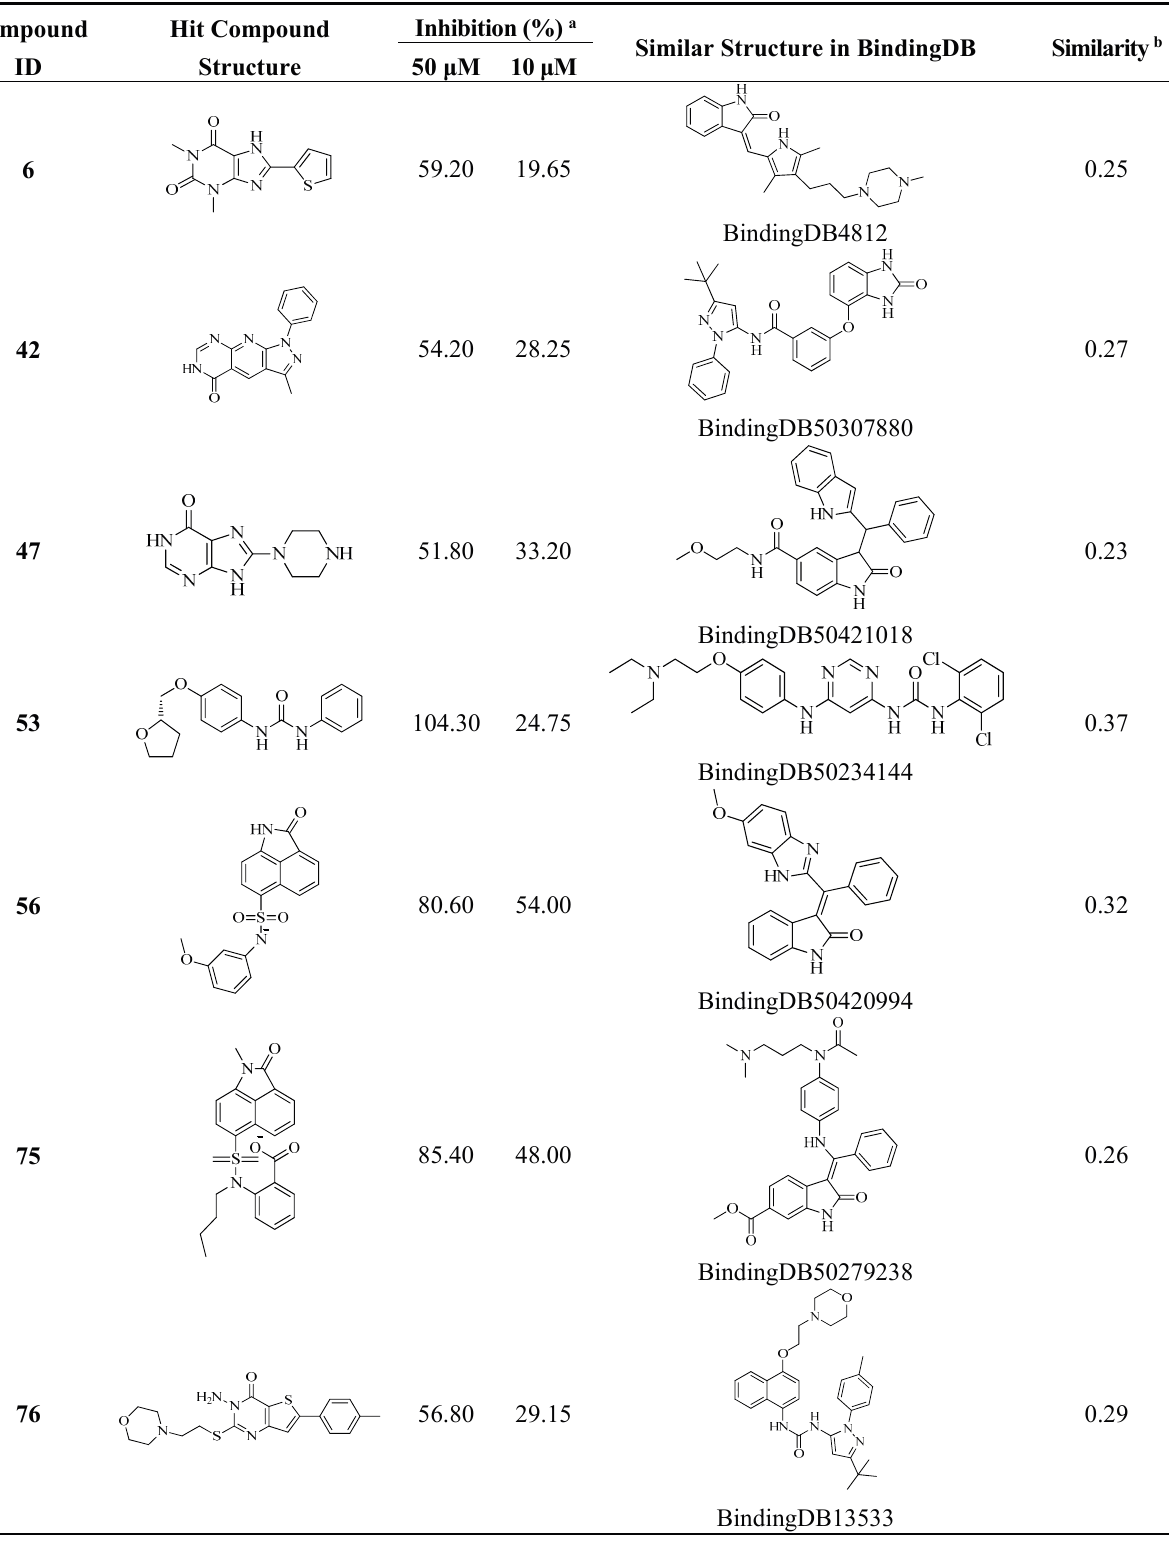
Table 4. FGFR1 enzyme inhibition rate of hit compounds, and the corresponding most similar compounds from